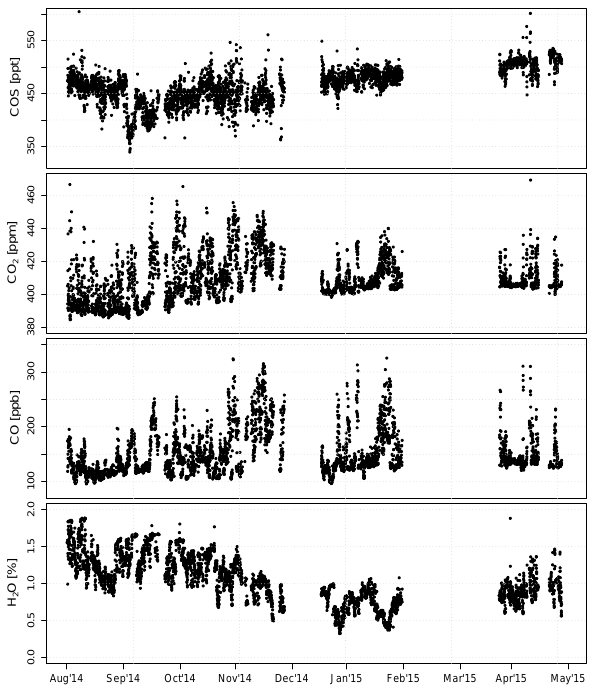
Figure 12. Hourly-averaged measurements of COS, CO 2 , CO and H 2 O in ambient air at the 60m level of the Lutjewad measurement tower as measured by the QCLS. Data are shown with corrections as described in the text.